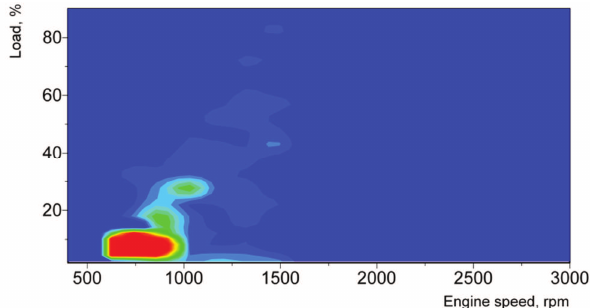
Fig. 6. Engine load frequency as a function of engine speed and load for urban traffic